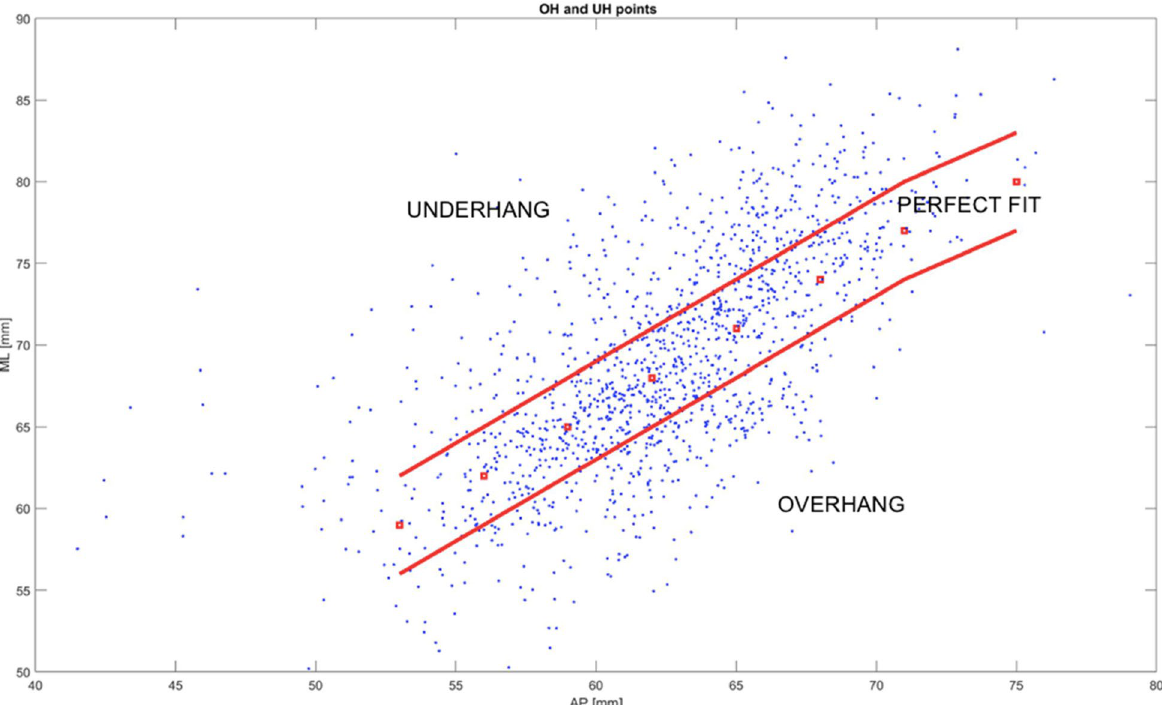
Fig. 7 Subadequate fitting of the current OTS femoral component sizes on the ML axis. The red dots represent the femoral system, named “P1” sizes, each dot represents one patient femur The 2 red lines were drawn at 3 mm from each size, for a given femoral AP dimension. The dots within the red lines are the one that have an appropriate fit the ones falling out have instead an inadequate fit in ML minus (overhang) or plus (underhang). It is assumed a perfect fit scenario falls for a given AP for a ML tolerance of